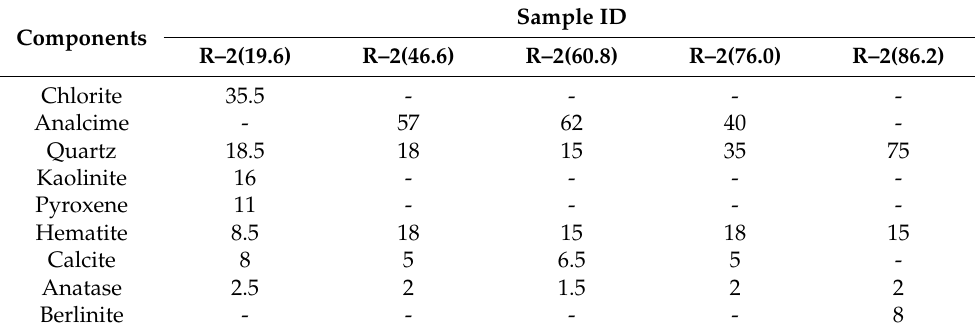
Table 6. Mineral composition of volcanic tuff core samples from Radoshivka–2 well (% w / w